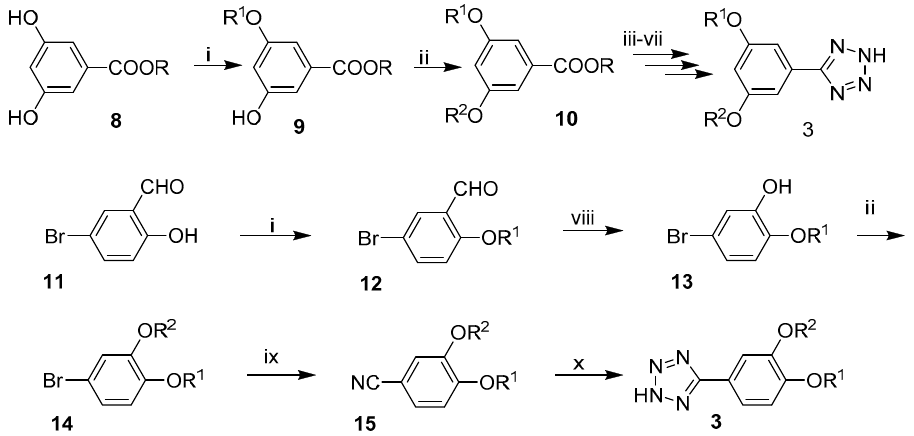
Table 4. Substitution pattern of r -TTTs and thermal